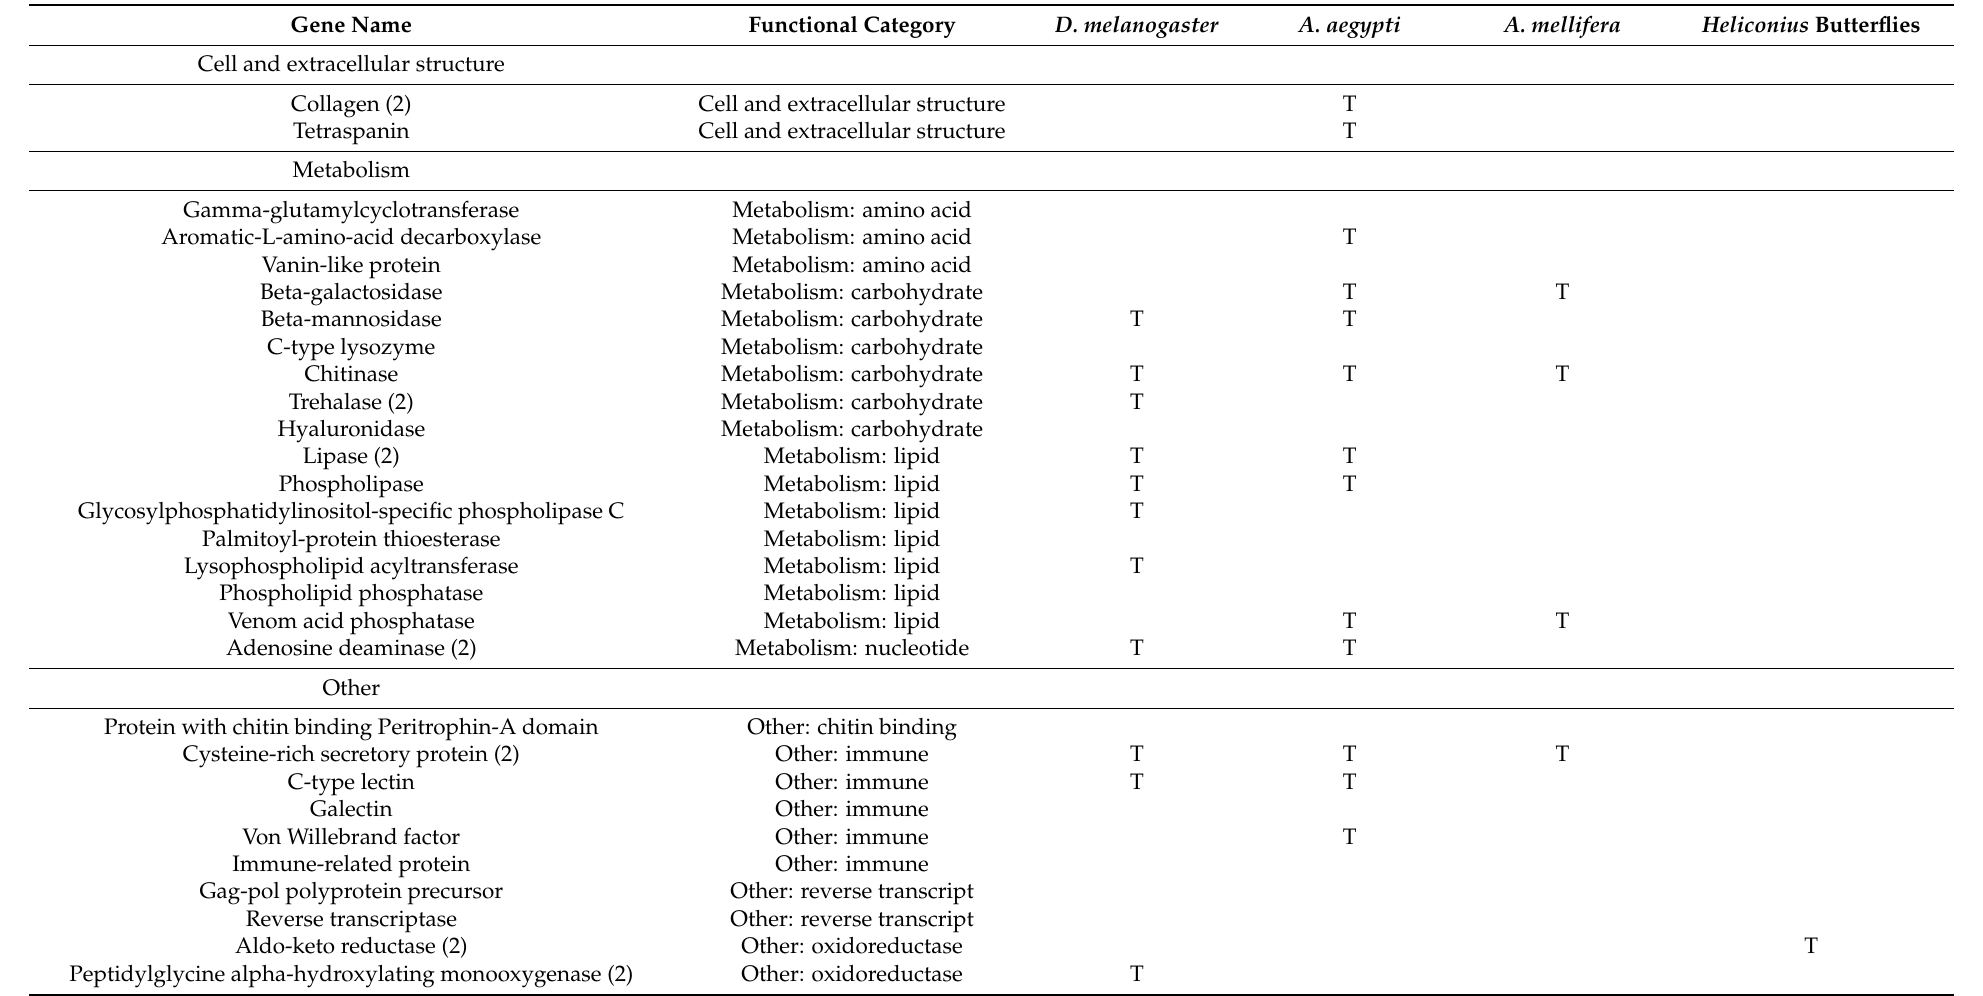
Table 1. Identified secreted ACPs of Plutella xylostella